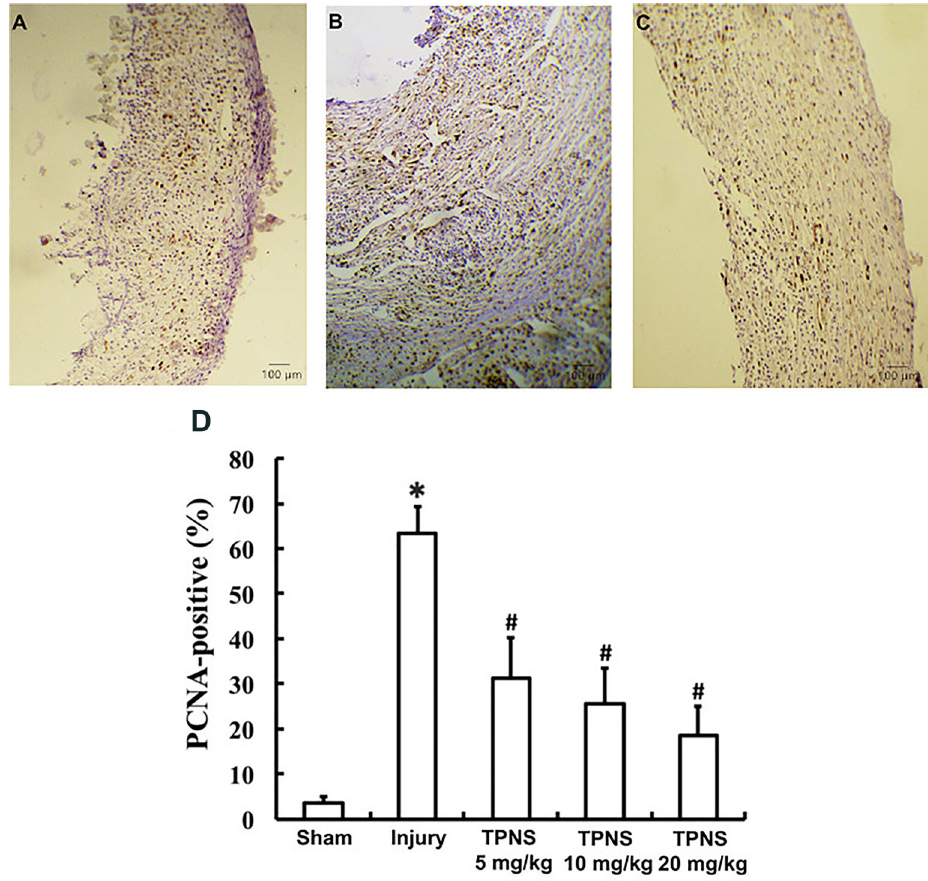
Figure 2. Inhibitory effect of total Panax notoginseng saponin (TPNS) on the percentage of PCNA-positive cells in the neointima of balloon-injured carotid arteries of rats. Representative sections (original magni fi cation 100 (cid:1) , bar: 100 m m) of carotid arteries with PCNA immunohistochemistry staining show almost no PCNA-positive cells in the sham group vascular walls ( A ), a large number of PCNA-positive cells in balloon injured vascular walls ( B ), and a decreased number of PCNA-positive cells in the high dose (20 mg (cid:3) kg – 1 (cid:3) day – 1 ) TPNS-treatment group ( C ). D , Data taken from the image manipulation system show changes of PCNA-positive cell percentage after TPNS administration at different doses for 14 days (percentage of PCNA-positive cell count per total cell count). Data are reported as means ± SE of 10 rats per group. *P o 0.05 compared to Sham; # P o 0.05 compared to injury (ANOVA and Tukey ’ s HSD post hoc